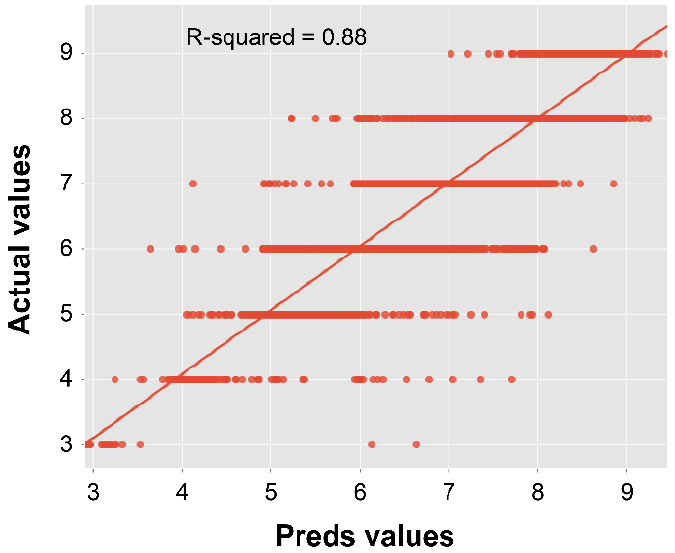
Figure 4. Test coefficient of the determination analysis for the substructure condition model.